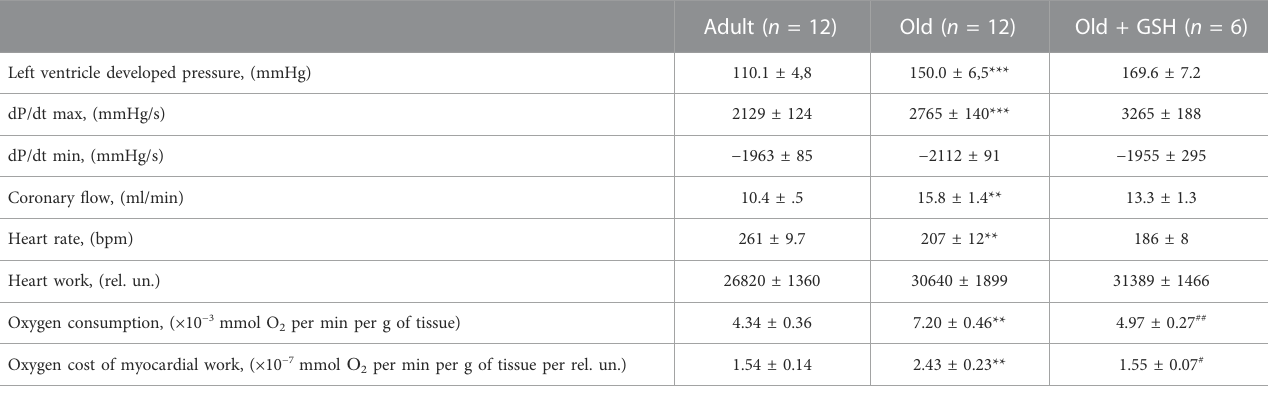
TABLE 3 Effect of GSH pretreatment at cardiodynamics of isolated heart of old